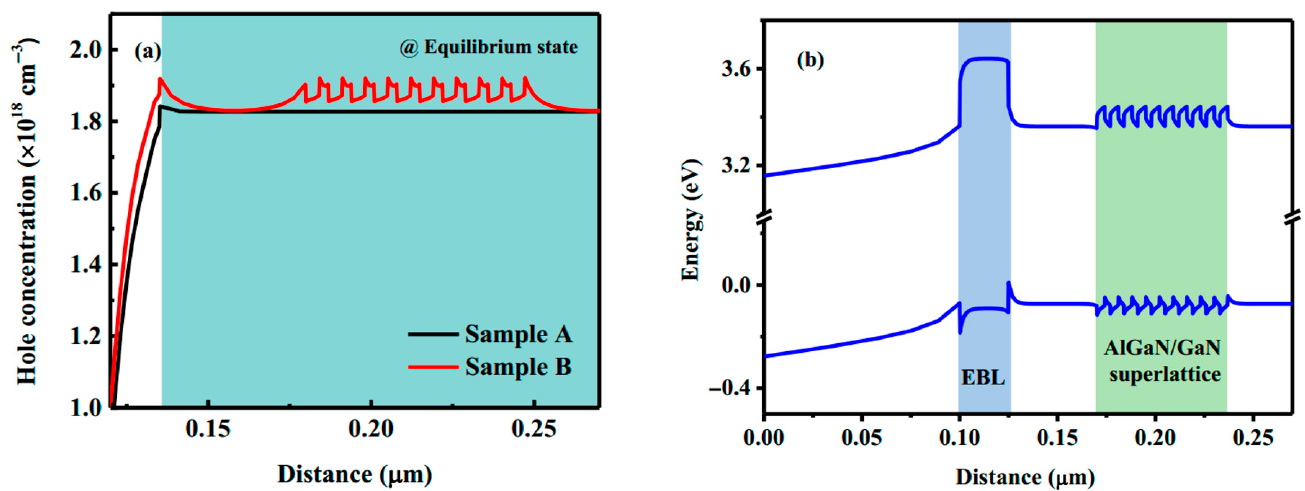
Figure 5. ( a ) Simulated hole concentration of both sample A and sample B, and ( b ) Simulated energy-band diagram of sample